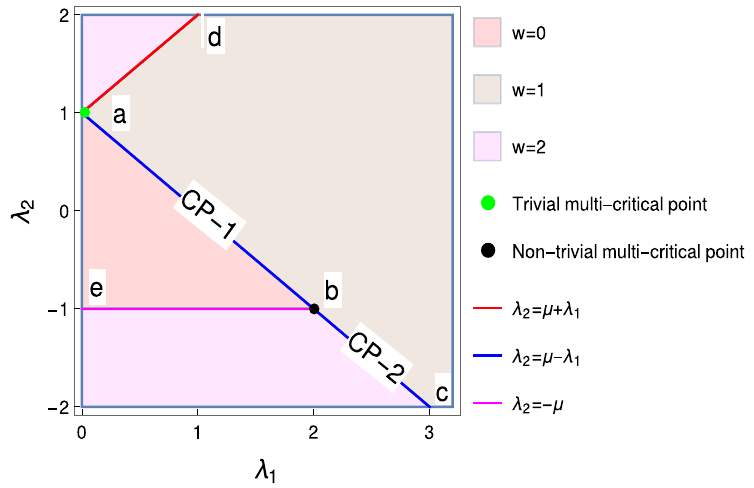
1 . Line ‘ac’ represents the critical line = (cid:31) µ (magenta line) and line ‘ad’ represents the 2 = − 0, 1, 2 (represented in different colors). Here = 0 and w 1 . CP-2 is critical/gapless phase for the = =